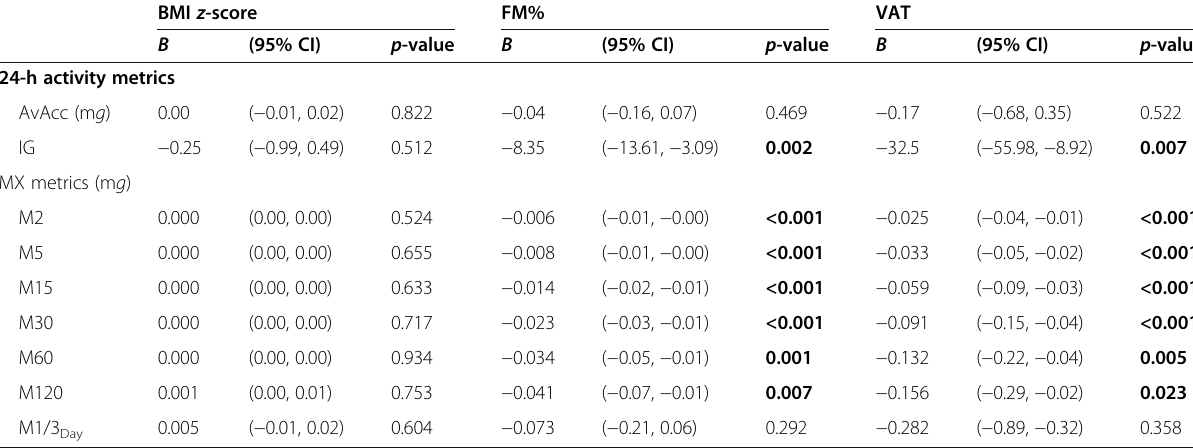
Table 3 Linear regression analysis of associations between 24-h activity metrics and adiposity indicators among adolescents ( n =